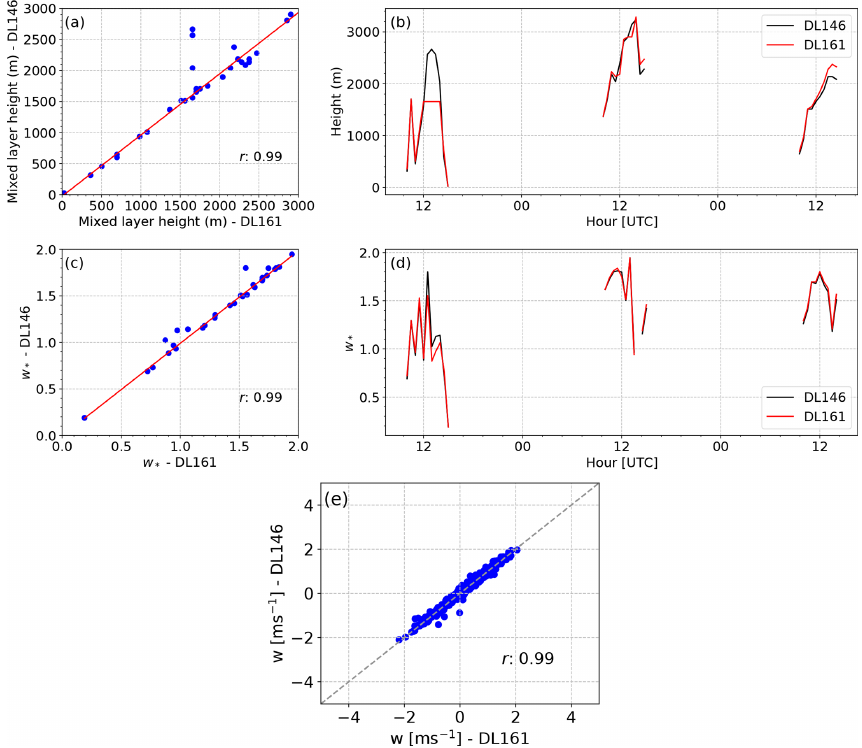
Figure 3. Comparison between the two co-located Doppler lidars, DL161 and DL146, during 23, 24 and 25 July 2021 within the time window 10:00–15:00UTC, except for 25 July only up to 14:30UTC on (a, b) mixed-layer height, (c, d) convective velocity scale and (e) 1min average of vertical velocity comparison at 120m.